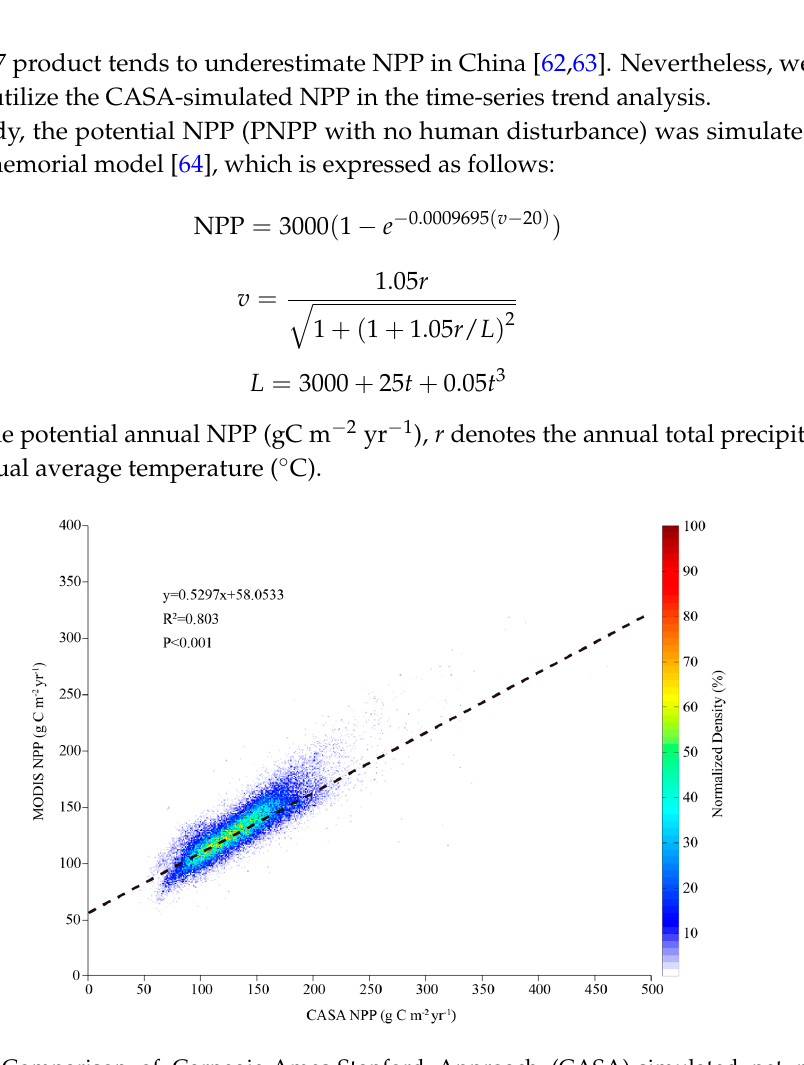
Figure 3. Comparison of Carnegie-Ames-Stanford Approach (CASA)-simulated net primary productivity (NPP) with the Moderate Resolution Imaging Spectrometer (MODIS) annual NPP product (MOD17A3) in the year